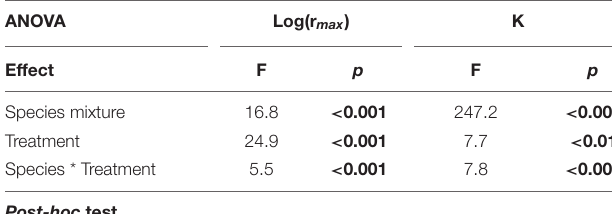
TABLE 3 | Two-species mixtures under constant